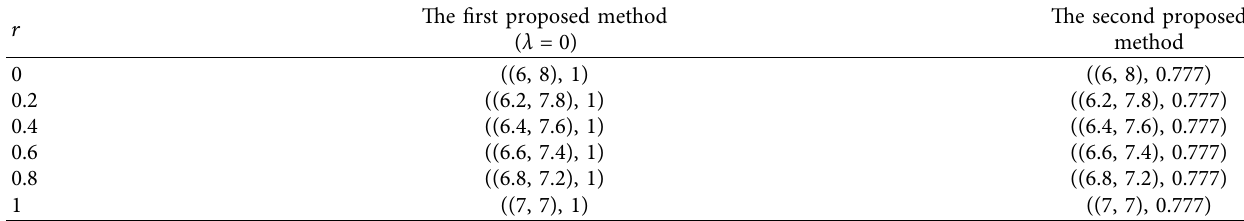
( r ) result using the two proposed methods ( λ � 0 ) . 1